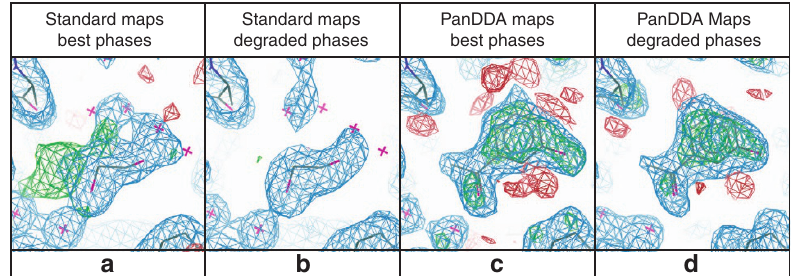
Figure 5 | Weak ligand identification remains straightforward when phases are degraded. BAZ2B data sets were re-analysed using a deliberately sabotaged reference model, introducing a B 30 (cid:2) phase error and increasing R work and R free by B 12% for all dimple-refined data sets. Shown here is the weak hit (refined occupancy: 0.64) in data set x492, contoured for different maps as labelled: ( a , b ) 1.78Å 2mF o –DF c (blue, 1 s ) and mF o –DF c (green/red, ± 3 s ). ( c , d ) 1.79Å event (blue, 2 s ) and Z -maps (green/red, ± 3). R work /R free are 0.18/0.21 and 0.30/0.32 for best and degraded phases, respectively. BDCs for best and degraded phases are 0.77 and 0.73, respectively. Whereas with standard maps, degraded phases remove all evidence of an unmodelled change, in PanDDA maps, ligand identification is no more difficult, even if the quality of the density is